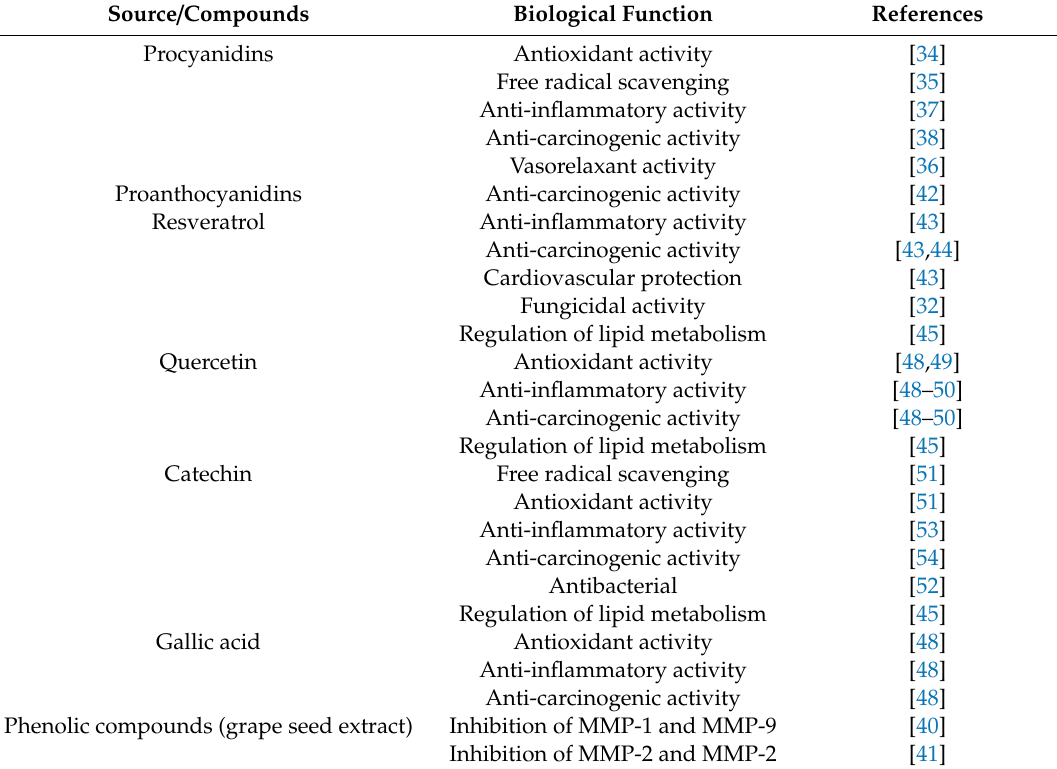
Table 1. Biological activities performed by phenolic compounds found in grape and its